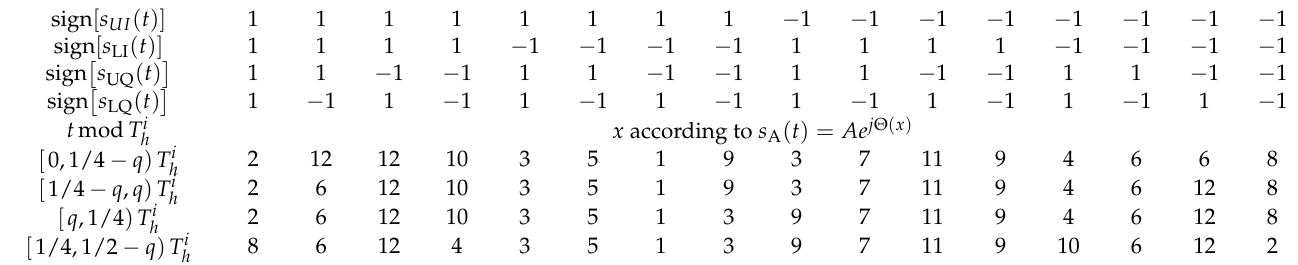
Table 1. LUT for Type-I ACE-FHBOC phase states (Where ϑ (cid:44) arctan ( λ ) and q (cid:44) ϑ /2 π